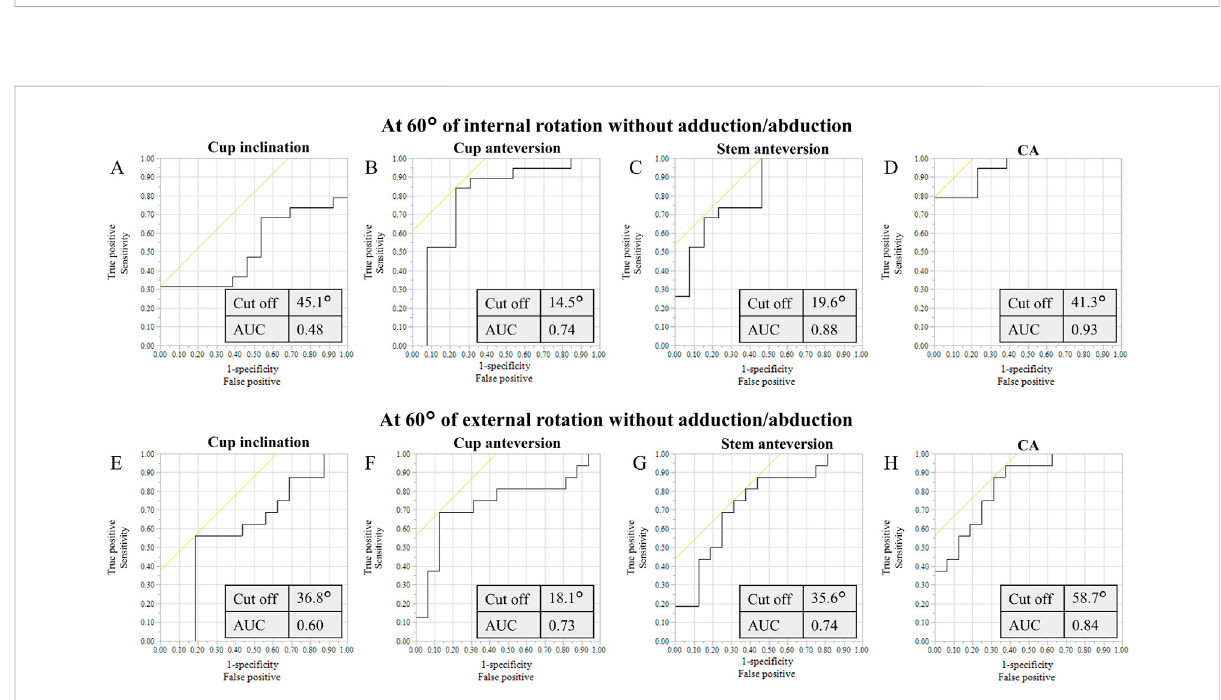
FIGURE 6 ROC curves ofthecupinclination (A) , cupanteversion (B) ,stem anteversion (C) ,and CA (D) to preventfrom anterior impingementatmaximum hip fl exionwithsimulated60 ° internalrotationand0 ° adduction.ROCcurvesofthecupinclination (E) ,cupanteversion (F) ,stemanteversion (G) ,and CA (H) to prevent from posterior impingement at maximum hip extension with simulated 60 ° external rotation and 0 °